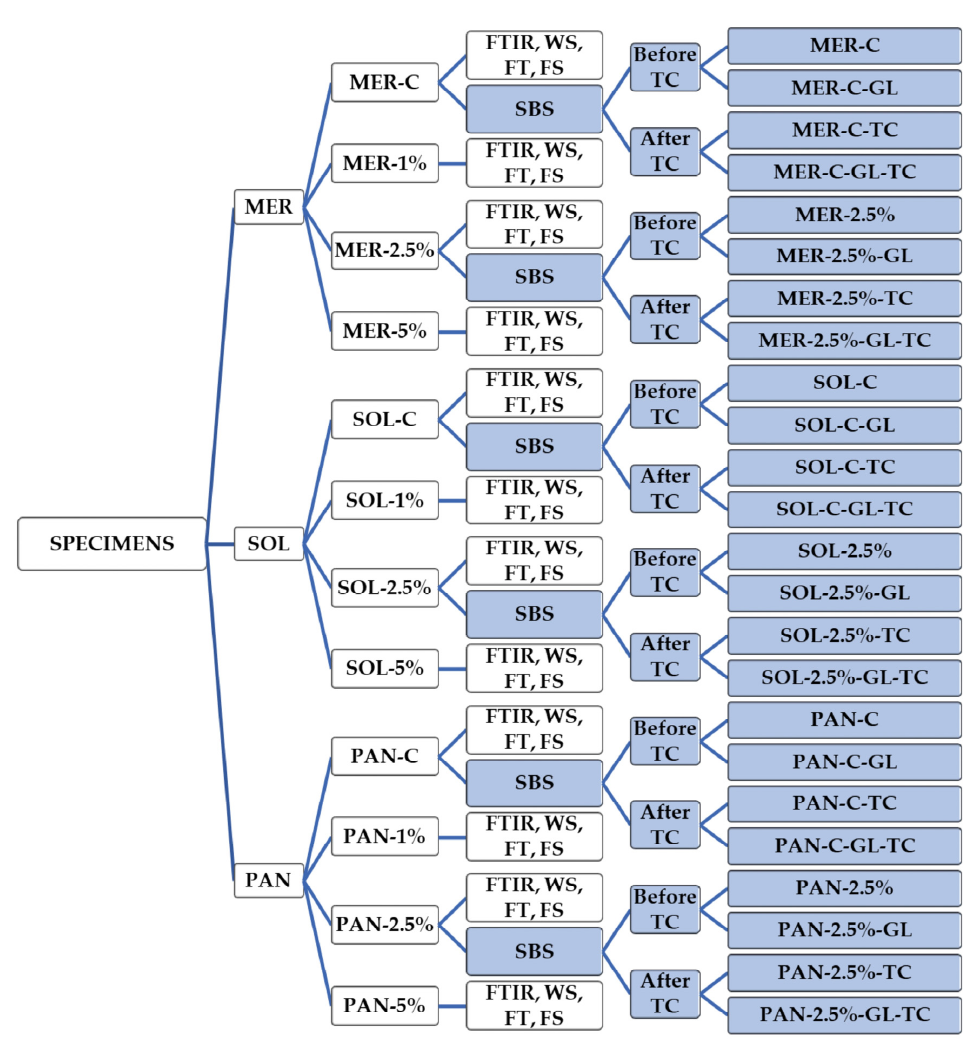
Figure 6. Schematic representation of the study groups and performed analysis. MER = Meron QM, SOL = Solocem, PAN = Panavia SA Universal, GL = Gluma, C = Control, FTIR = Fourier Transform Infrared Spectroscopy, WS = water sorption, FT = film thickness, FS = flexural strength, SBS = shear bond strength test, TC = thermocycling.